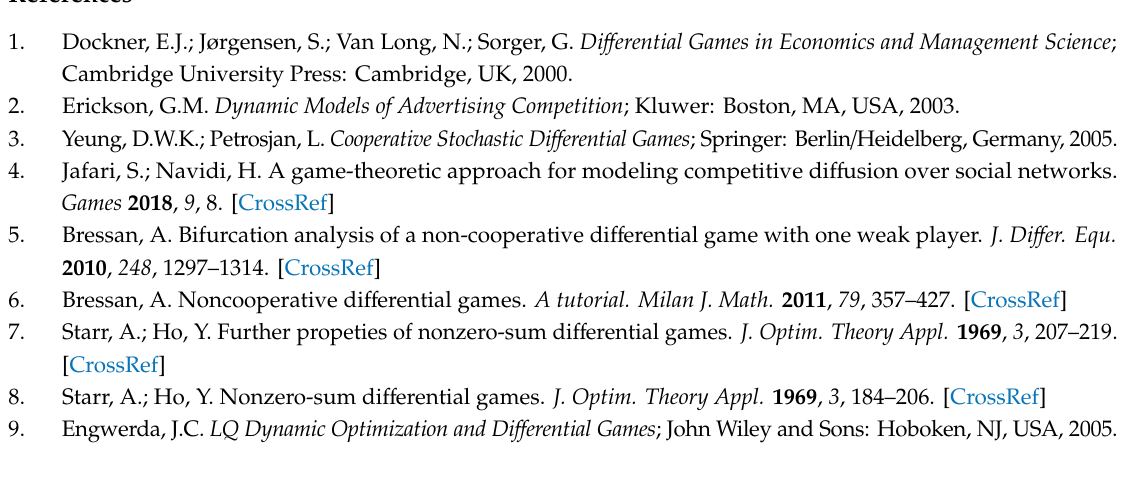
Figure 1. Plots of approximate open-loop Nash equilibrium for illustrative example when N = 14